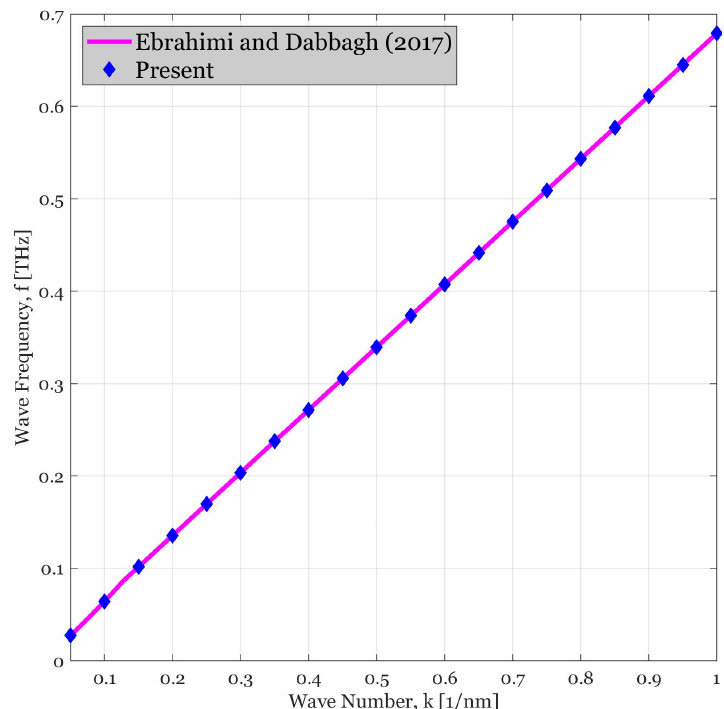
Figure 2. Comparison of the wave frequency versus wave number curve of the acoustic branch of waves dispersed in FG plates. The solid line is related to the response provided in [39] and the diamonds are the responses of present study.